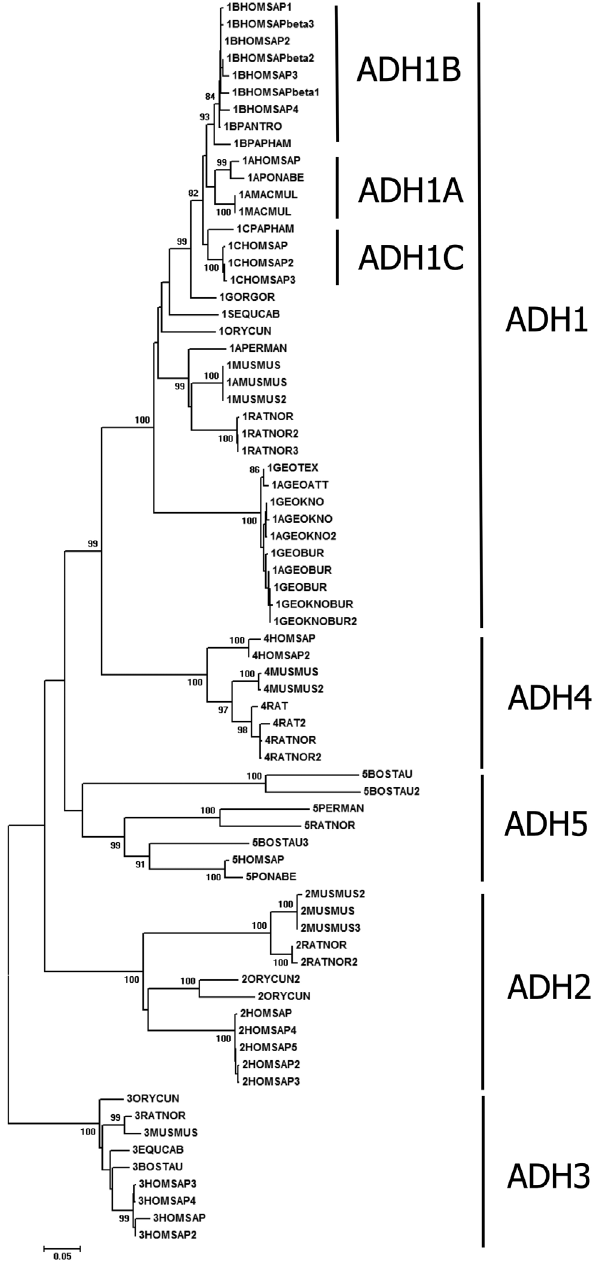
Figure 2 - Phylogenetic tree of alcohol dehydrogenase proteins from mammals obtained by the neighbor-joining algorithm. Numbers represent bootstrap values; values higher than 80% are shown. Scale bar indicates levels of sequence divergence. Clusters distinguishable by ADH type are